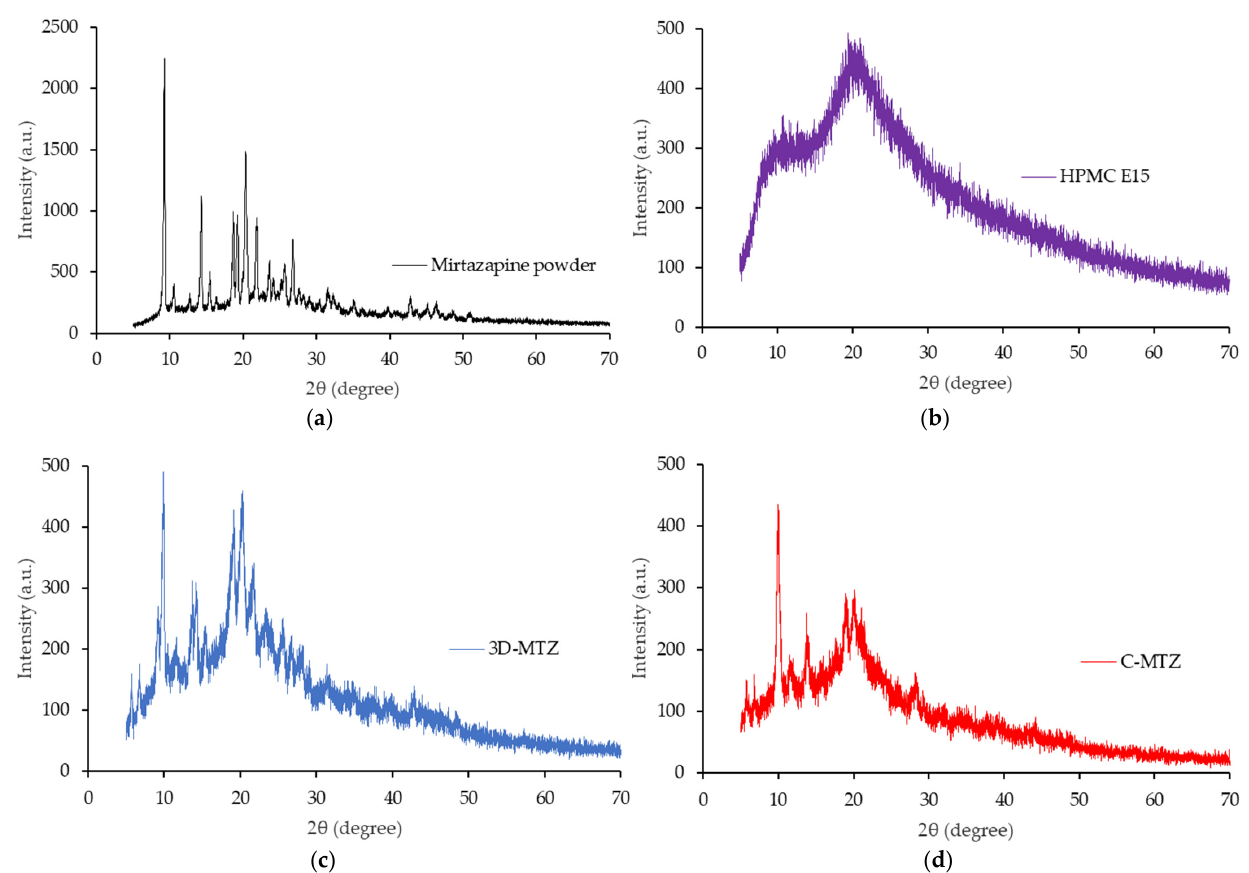
Figure 5. Diffractograms of mirtazapine powder ( a ), HPMC E15 ( b ), 3D ‐ MTZ ( c ) and C ‐ MTZ ( d ).